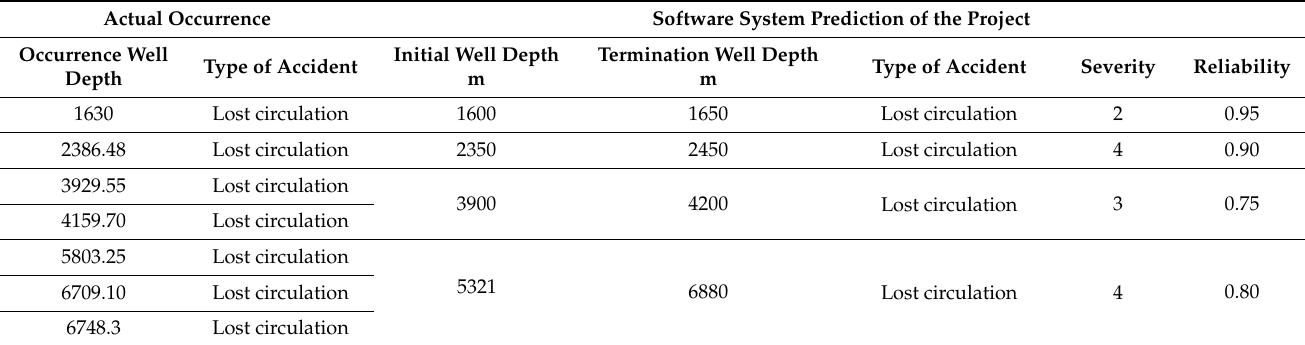
Table 5. Early warning result data of Yuanba well 12